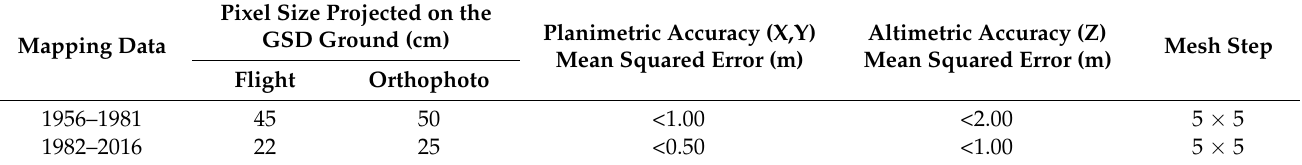
Table 2. Technical characteristics of the georeferenced data used. Mapping